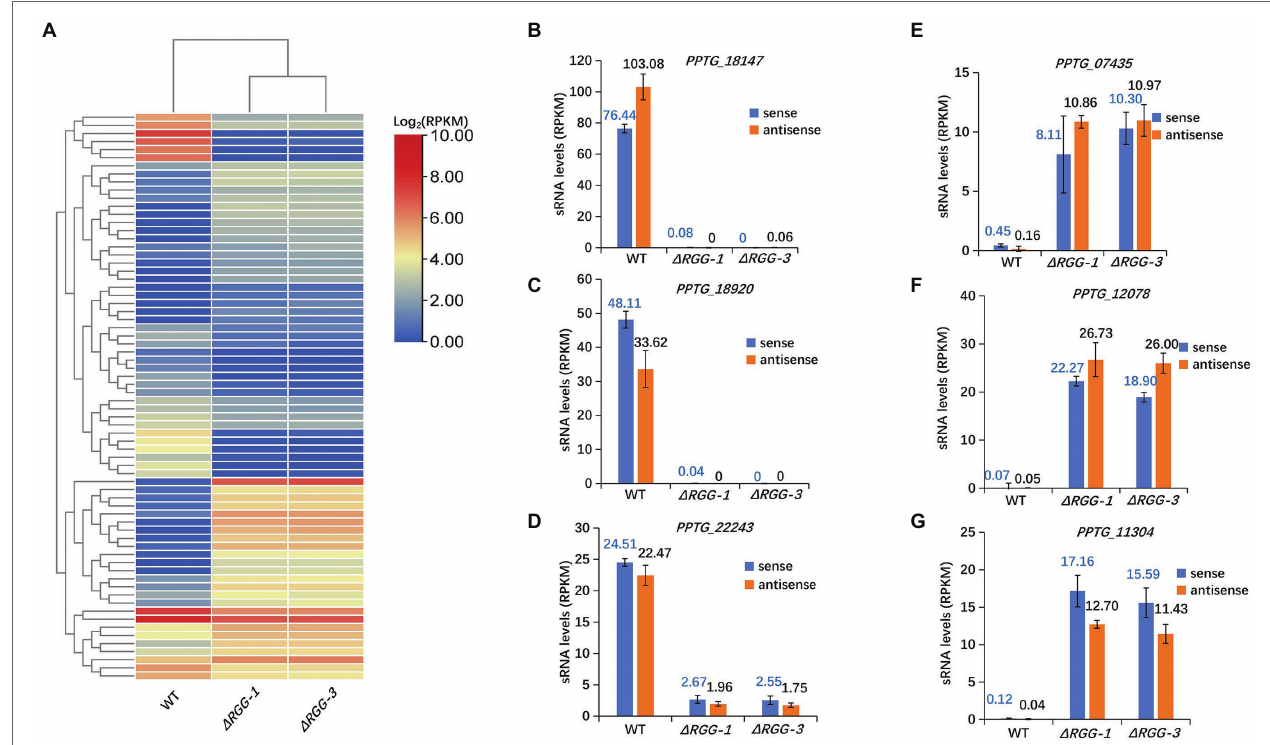
FIGURE 2 | Significant changes in accumulation of 25–26 nt sRNAs homologous to70 cytoplasmic effector genes in mutants PpAGO3 Δ RGG1 and PpAGO3 Δ RGG3 compared to the wild-type P. parasitica . (A) Heatmap for 25–26 nt sRNA accumulation in wild-type, and mutants PpAGO3 Δ RGG1 and PpAGO3 Δ RGG3 . The accumulation of 25–26 nt sRNAs was increased for those associated with 24 RXLR and 17 CRN effector genes, and was reduced for those associated with 12 RXLR and 17 CRN effector genes in mutants PpAGO3 Δ RGG1 and PpAGO3 Δ RGG3 . The color represents the transformation value of log 2 (RPKM). (B-G) The expression